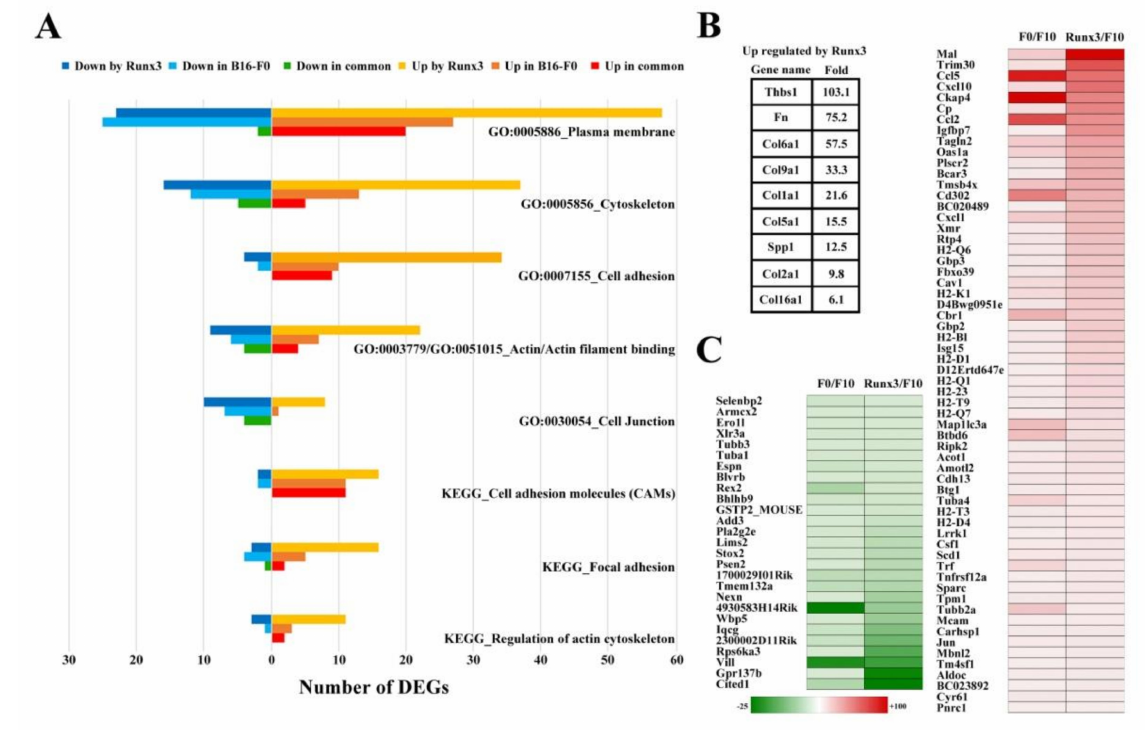
Figure 2. Microarray analysis uncovered an altered and specific transcriptional profile underlying the cell shape change and the suppression of the metastatic potential by Runx3. ( A ) Gene Ontology (GO) and Kyoto Encyclopedia of Genes and Genomes (KEGG) annotations assigned different repertoires of differentially expressed genes (DEGs) that were regulated by Runx3 in B16-F10 cells and, in the case of B16-F0 cells vs. B16-F10 cells, to the terms relevant to the actin cytoskeleton and adhesion. Each GO/KEGG annotation term is inscribed as a caption. The number of DEGs within a repertoire is described at x axis. The columns for the downregulated and the upregulated DEGs are shown in different colors as explained at the top of the figure., Down/Up by Runx3 indicates the appearance of DEGs in the case of B16-F10/Runx3 cells vs. mock control B16-F10 cells. Down/Up in B16-F0 indicates the appearance of DEGs in the case of B16-F0 cells vs. B16-F10 cells. Down/Up in common indicates the appearance of same DEGs in both cases. ( B ) Runx3 upregulated the expression of extracellular matrix (ECM) genes. The summary table indicates the gene names and their corresponding fold changes. ( C ) Runx3 regulated the expression of a list of DEGs that were inversely associated with an increase in the metastatic potential of B16-F10 cells compared to B16-F0 cells. The heatmap shows the gene names and their fold changes in the cases of B16-F10/Runx3 cells vs. mock control B16-F10 cells and B16-F0 cells vs. B16-F10 cells,